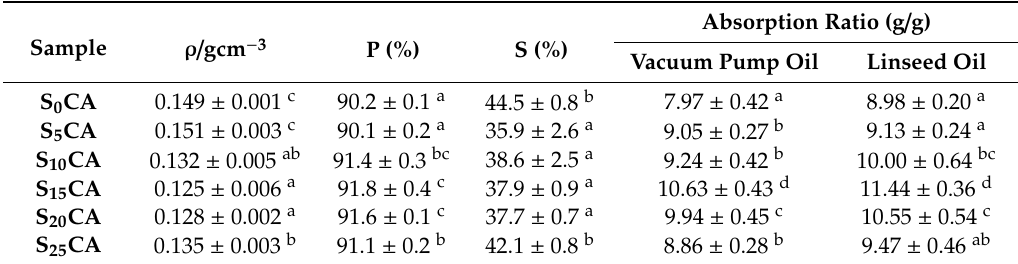
Table 1. Density ( ρ ), porosity (P), volume shrinkage (S), and absorption rate of the aerogels with di ff erent starch